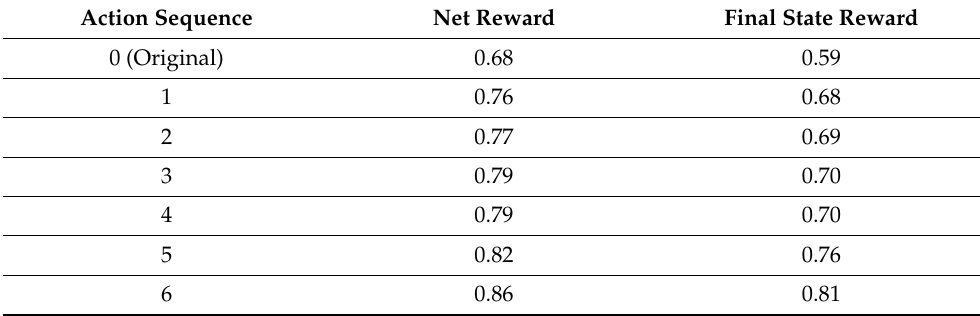
Table 6. Summary of the rewards associated with the different action sequences.